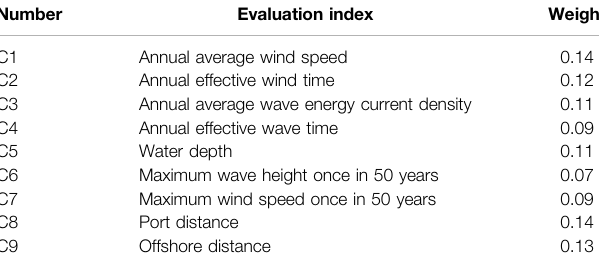
TABLE 2 | Evaluation criteria for COWWF siting in Zhejiang